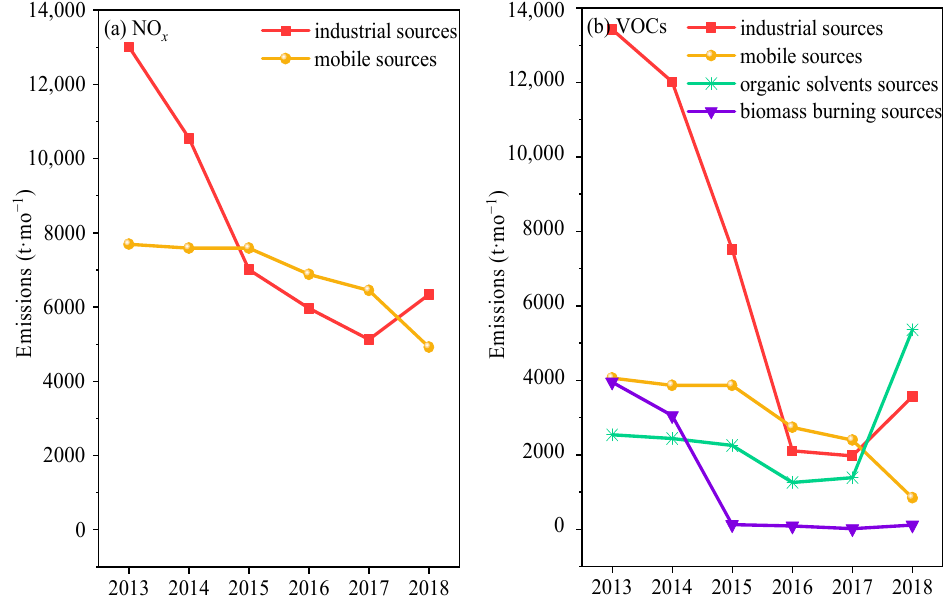
Figure 5. Changes in emissions from the main sources of anthropogenic ( a ) NO x and ( b ) VOCs in Handan during June of 2013–2018.